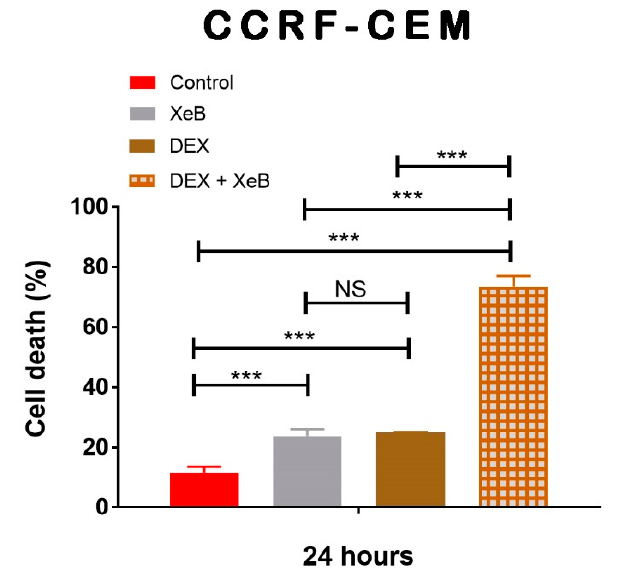
Figure 8. The inhibition of InsP3R with XeB enhances cell death in the presence of dexamethasone in CCRF-CEM cells. CCRF-CEM cells were treated with 5 µ M XeB, 10 µ M dexamethasone (DEX), or a combination of 5 µ M XeB plus 10 µ M dexamethasone (DEX) for 24 h and cell death was determined by propidium iodide incorporation by flow cytometry n = 3, mean ± S.E., *** p < 0.001 ( t -test), NS = not significant ( t -test).